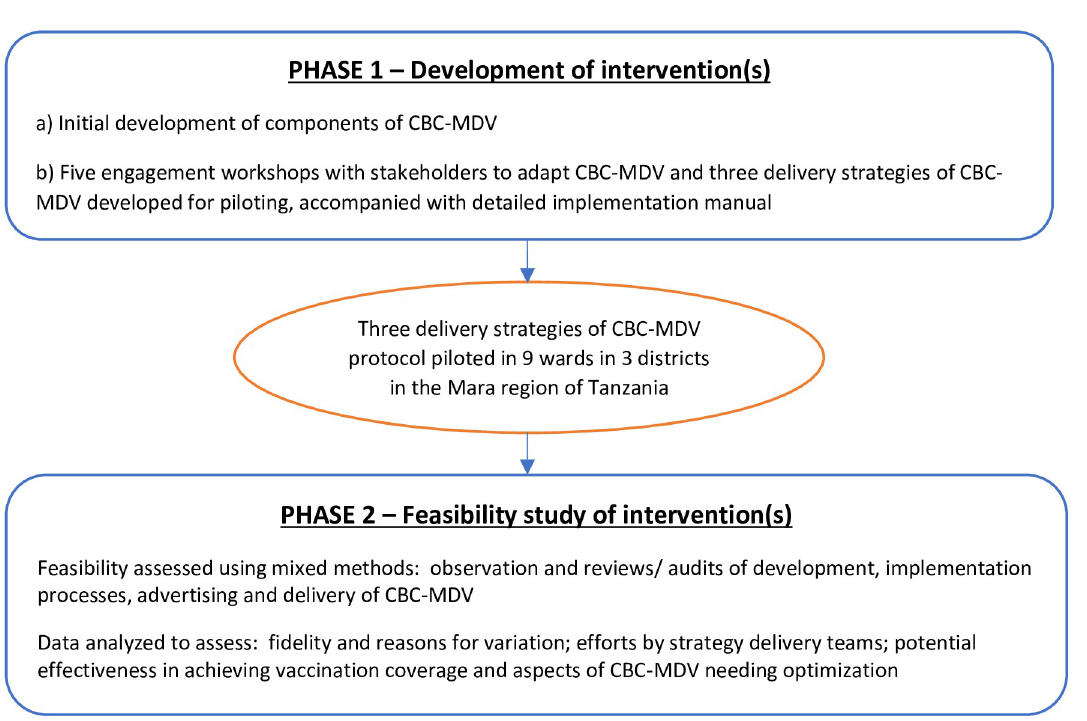
Fig 1. Flow of development and optimization process of the community-based continuous mass dog vaccination approach prior to full-scale evaluation.